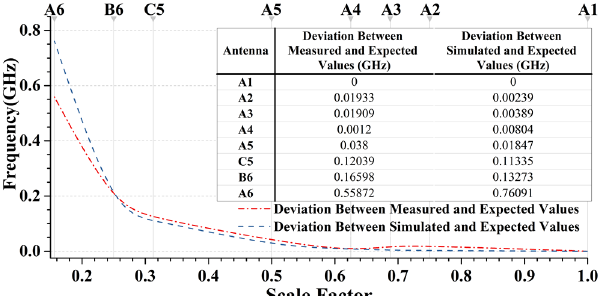
Figure. 5. Deviation of measured and simulated resonant frequency in respect with the expected resonant frequency of antennas.